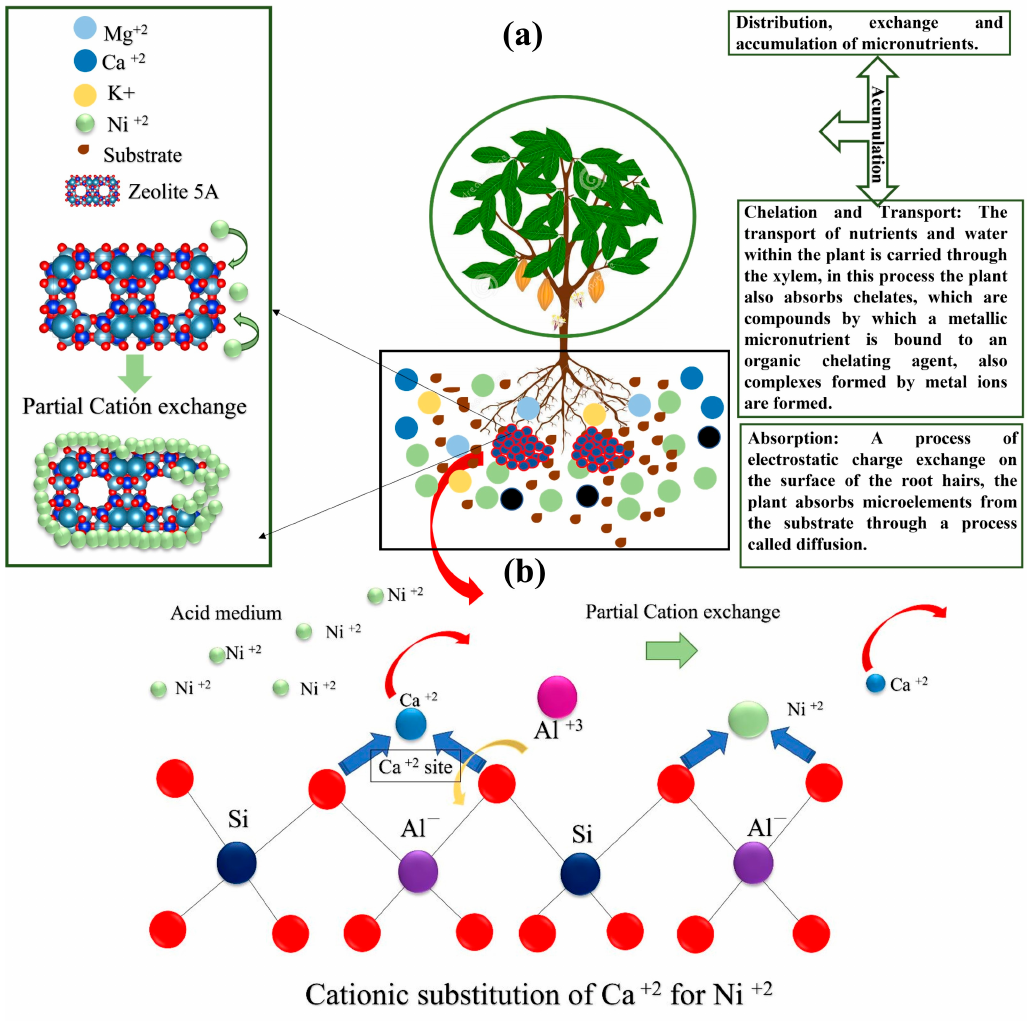
Figure 13. ( a ) Graphical scheme of Ni mobility and adsorption. ( b ) Scheme of cation exchange within the zeolite 5A structure.